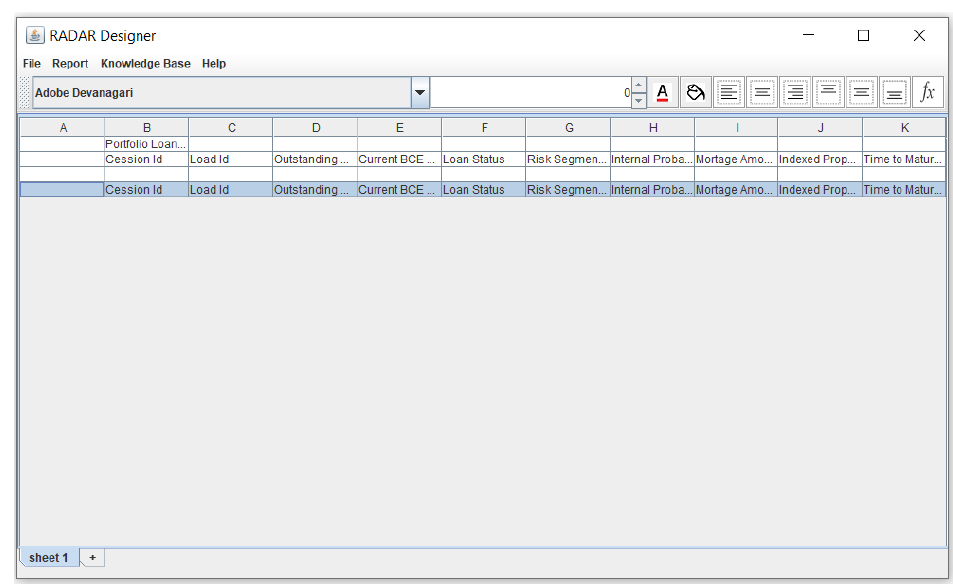
Figure 14. Report Designer : definition of a “detail table” in the worksheet called LoanByLoan within a report